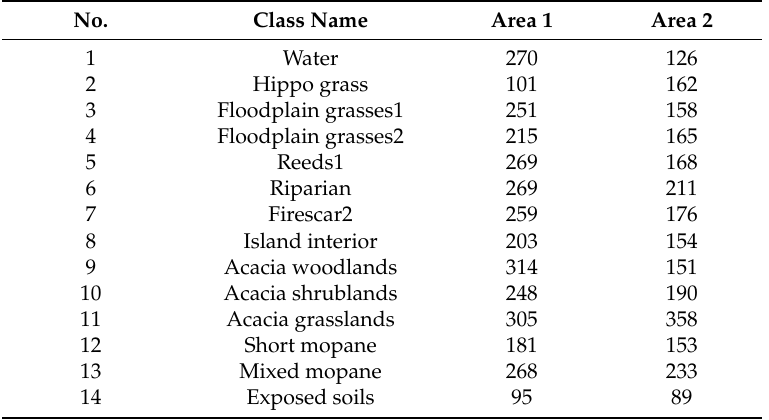
Table 1. Class names and number of data points for the Botswana data set. No. Class Name Area